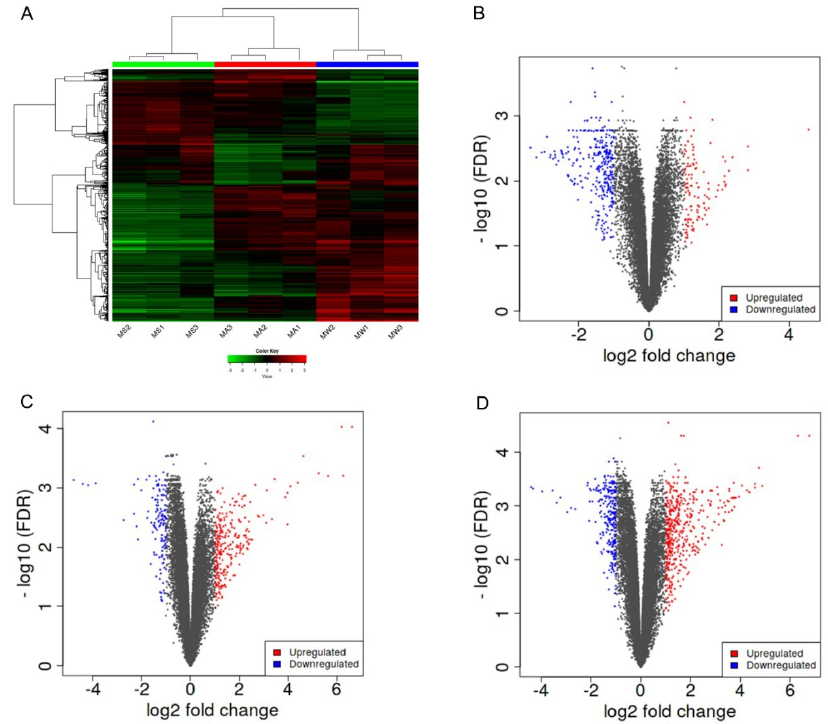
Figure 4. Differentially expressed genes (DEG) in three comparisons of sample groups. ( A ) the presence of DEG in the three comparisons of sample groups; ( B ) DEG volcano plot between MS (summer) and MW (winter) groups; ( C ) DEG volcano plot between MS and MA (autumn) group; ( D ) DEG volcano plot between MW and MA group.